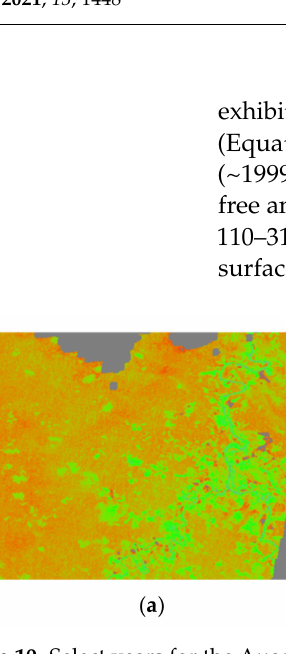
Figure 10. Select years for the August Landsat time series EMSI in Acre state, Brazil ( a ) during drought-like highly stressed conditions in 2001, note the areas along the river on the east side appear as above normal, due to the time series including their subsequent conversion to agriculture which has much lower NDVI and thus lower EMSI, ( b ) above normal and robust conditions in 2013, agricultural areas along the river are still within normal condition, and ( c ) an above normal year in 2020 with the continued expansion of agricultural areas along the eastern side. Pixels with no data due to masking are gray.